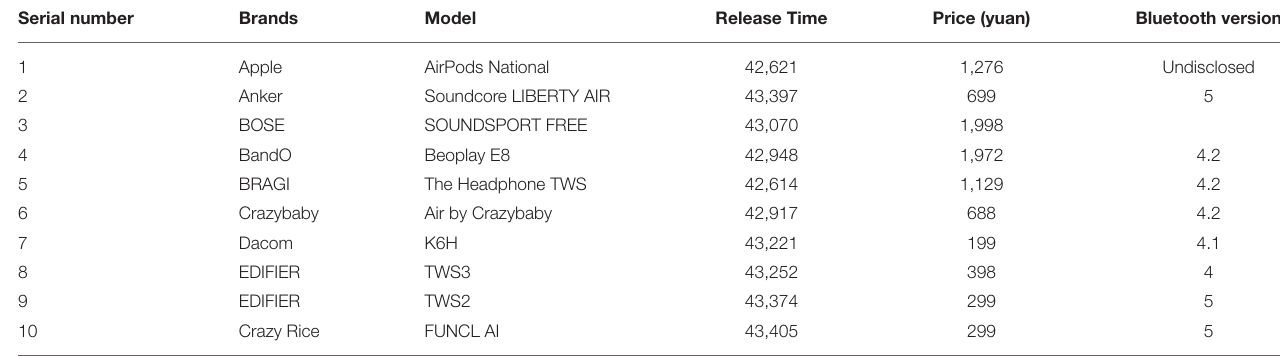
TABLE 2 | Mobile phone brands and their calculation